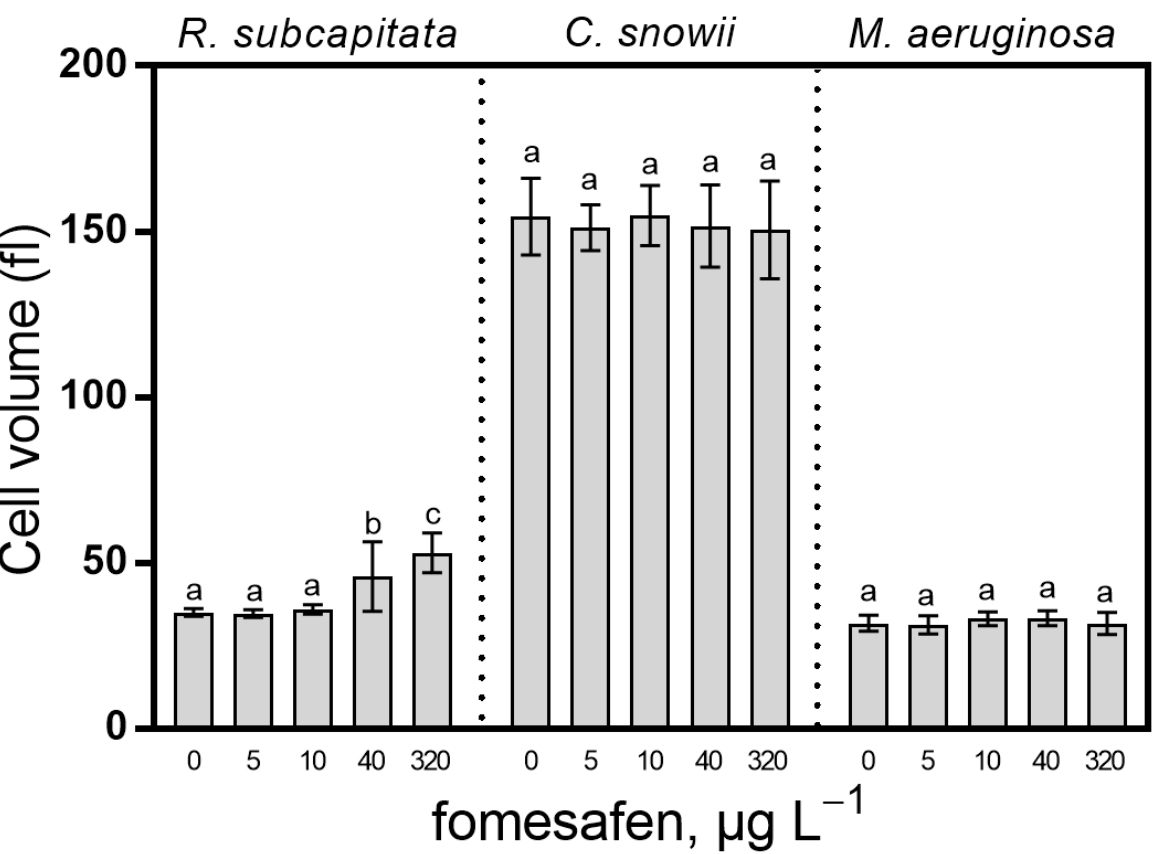
Figure 7. Cell volume of R. subcapitata , C. snowii and M. aeruginosa after 72 h exposure to five con- centrations of fomesafen a.i. (0, 5, 10, 40 and 320 µg · L − 1 ). Cell biovolume is expressed as mean femtoliter ± SD; n = 9. Bars indicate the means ± standard deviation of nine replicates. Means fol- lowed by the same letter are not significantly different by the Tukey–Kramer HSD test or the Krus- kal–Wallis test on ranked means.